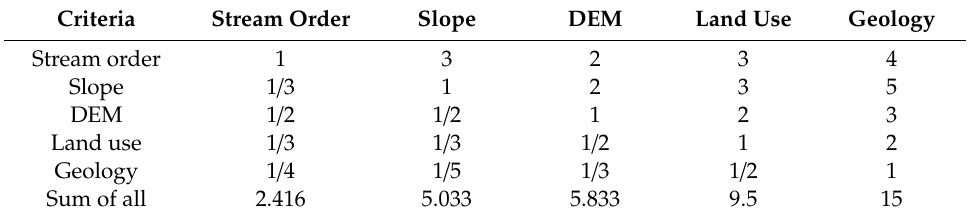
Table 3. Pairwise comparison matrix with intensity judgments (preference matrix).